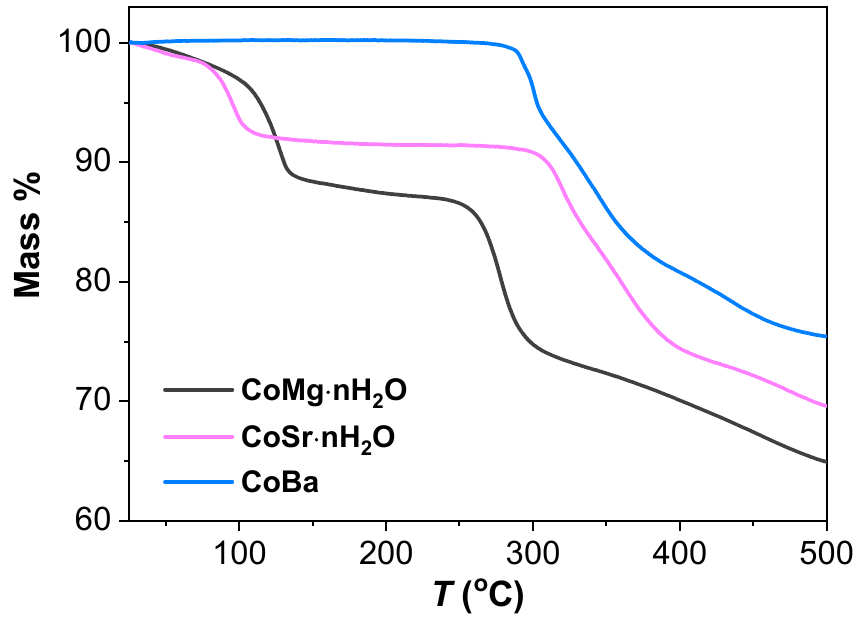
Figure 5. The thermogravimetric curves of CoMg·nH 2 O , CoSr·nH 2 O , and CoBa.